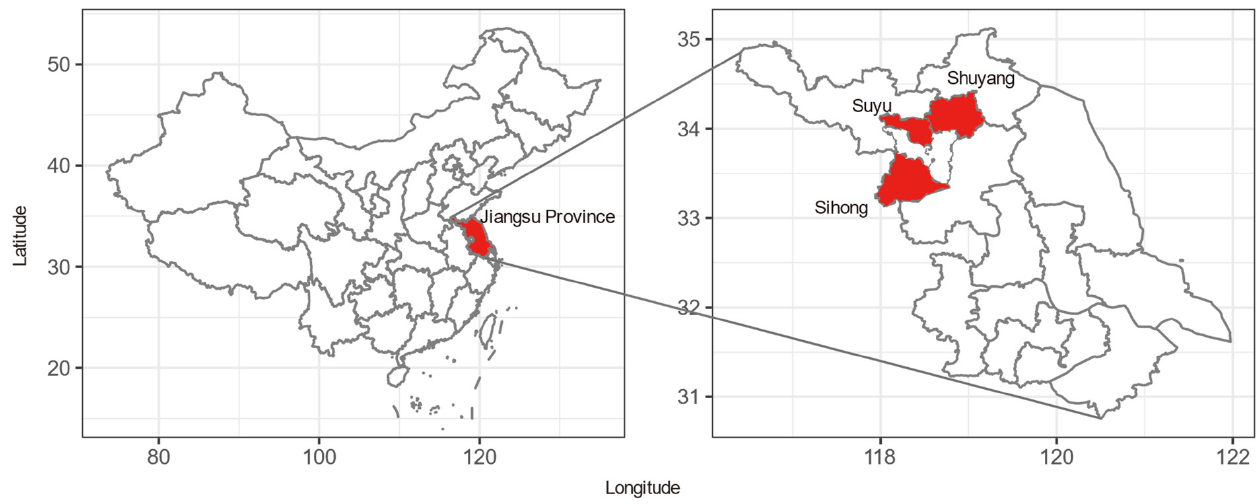
Figure 1. The sample collection area was located in the northern part of Jiangsu Province. The red area represents three farm types: Suyu henneries, Shuyang gooseries, and Sihong dairy farms.